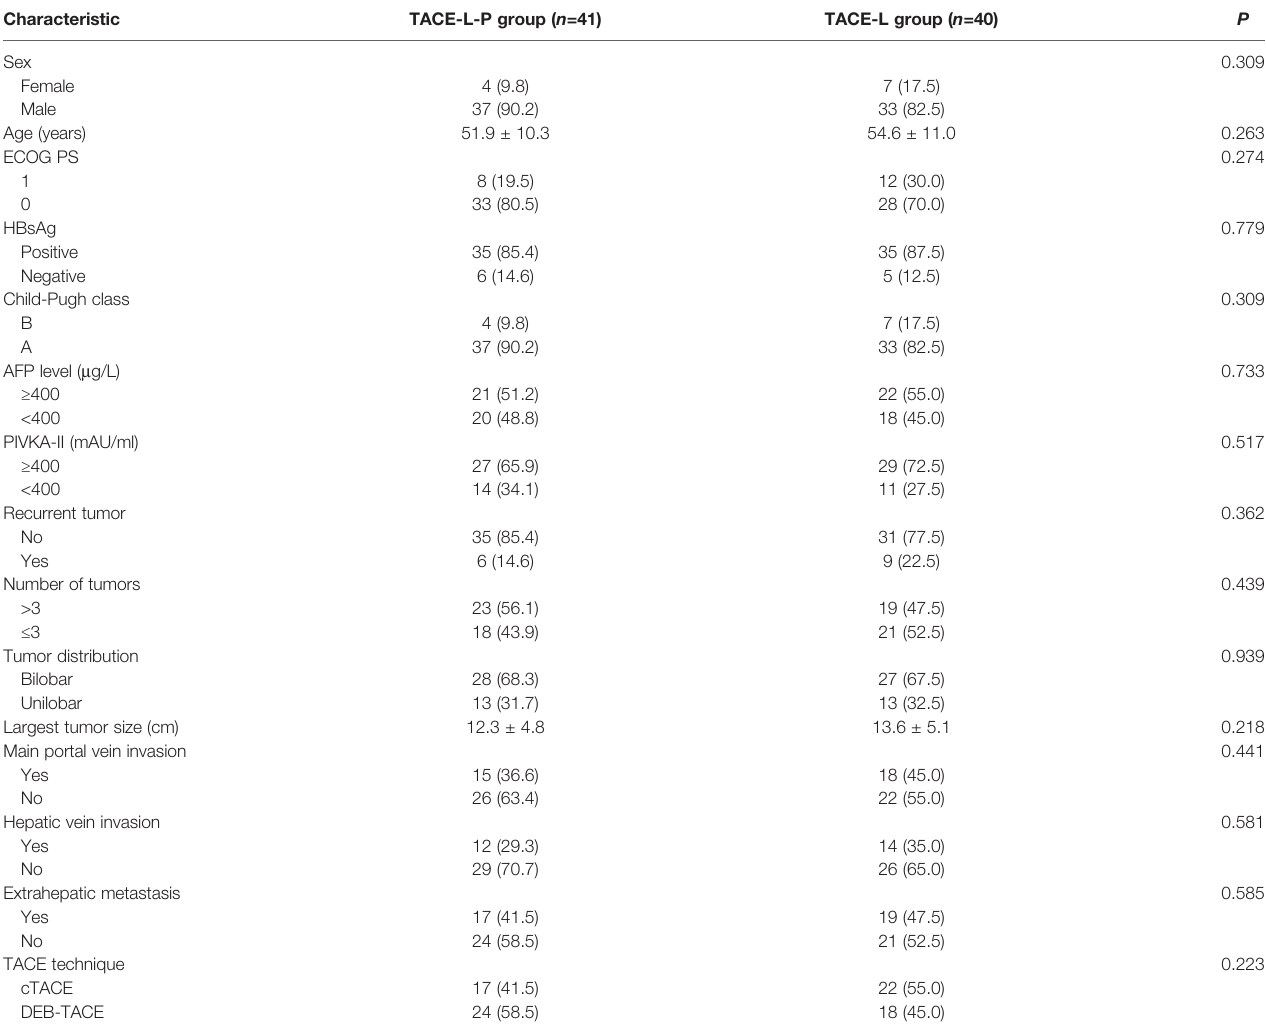
TABLE 1 | Baseline characteristics of the patients.